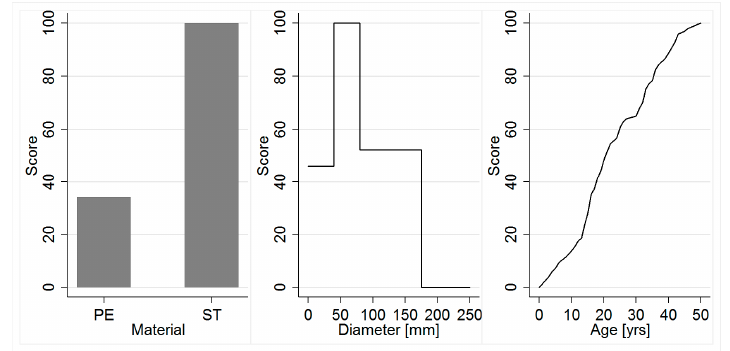
Figure 4. Scores of the condition driven criteria for the gas distribution network.